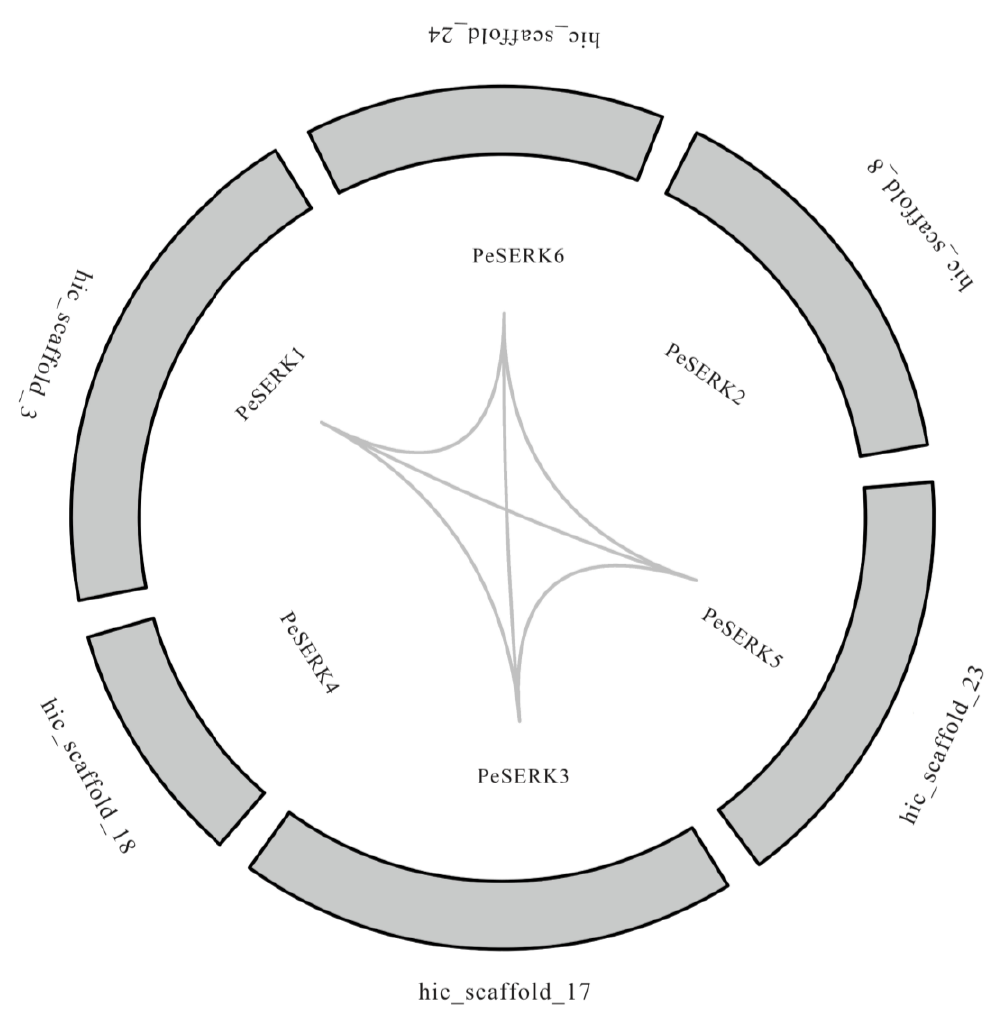
Figure 4. Chromosome locations and syntenic relationships between PeSERKs in moso bamboo. Gray lines indicate the syntenic PeSERK gene pairs.